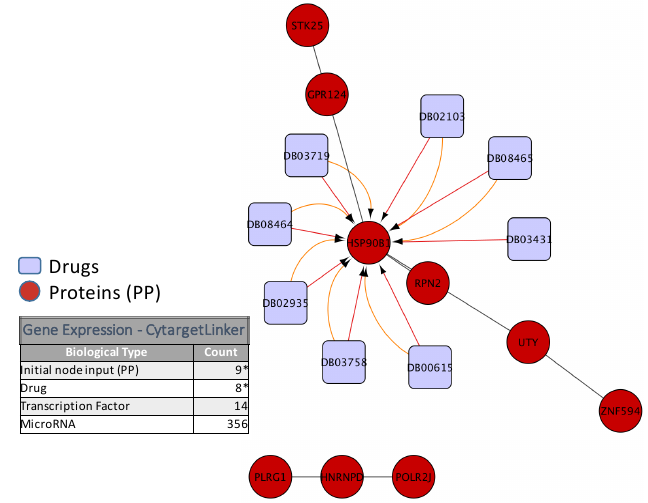
Figure 5. Protein and drug interactions among top features selected in gene expression data. The top 50 genes selected from gene expression data are passed to the STRING database to find protein-protein interaction. Then, this new network is passed to Cytoscape using the CyTargetLinker App to extend the Protein-Protein (PP) interactions in a 7759 drug database (DrugBank); only the elements marked with an * are displayed in this